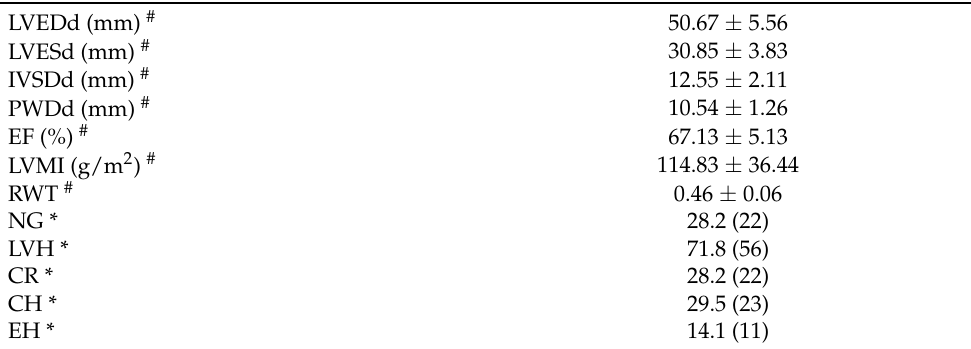
Table 3. Echocardiographic parameters in the study group.